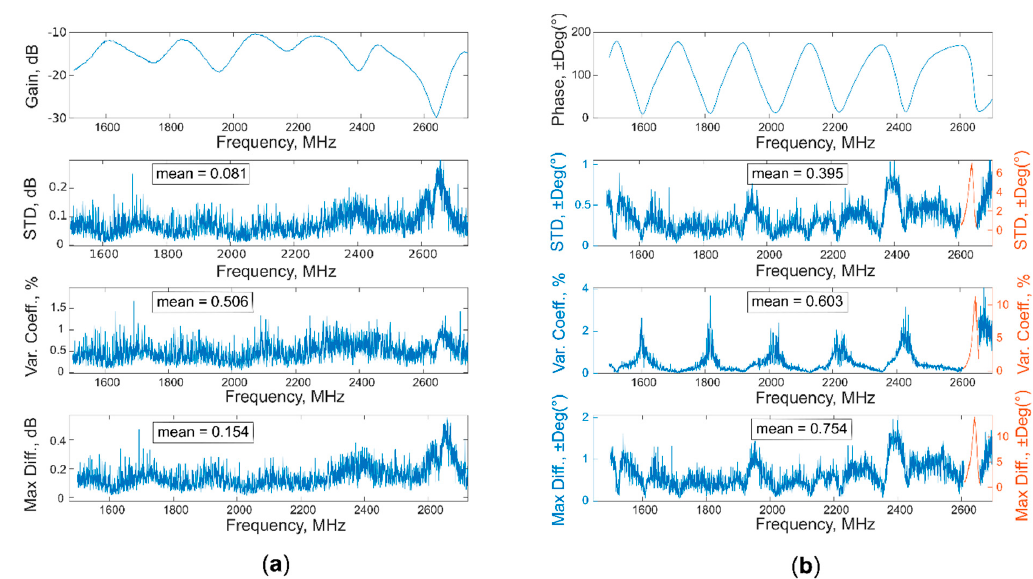
Figure 13. Standard deviation, coefficient of variation, and maximum difference calculated both for ( a ) gain and ( b ) phase, from a total of nine acquisitions on soil.